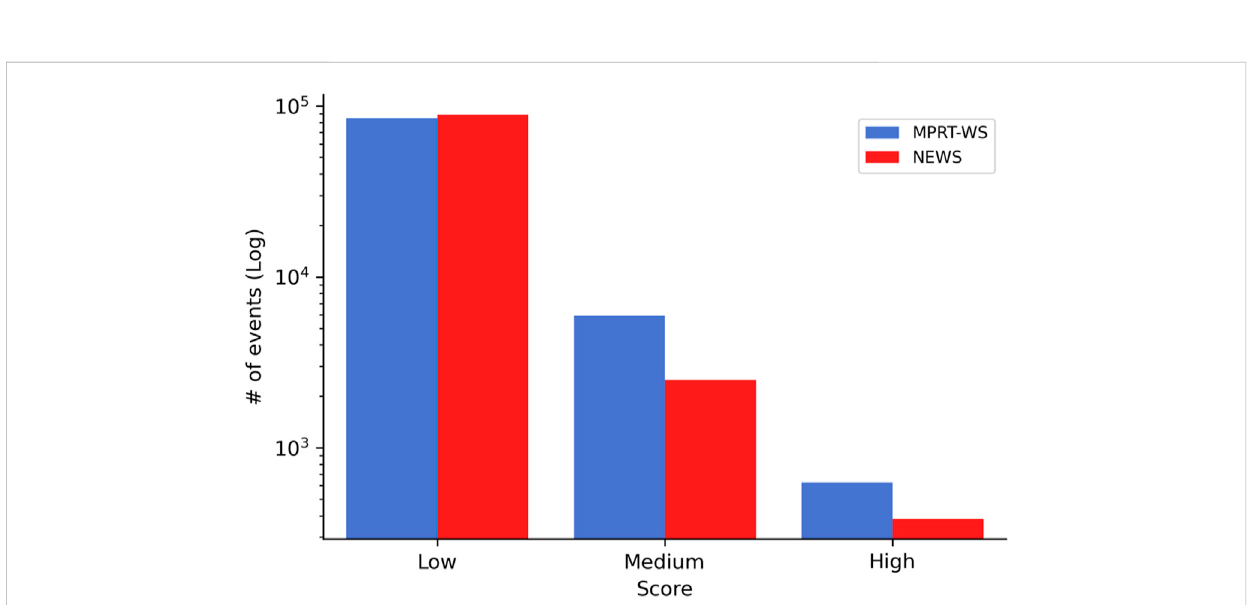
FIGURE 3 Comparing the risk score readings between the new alert tool and the currently-used NEWS system. Included are readings from the patients ( n =